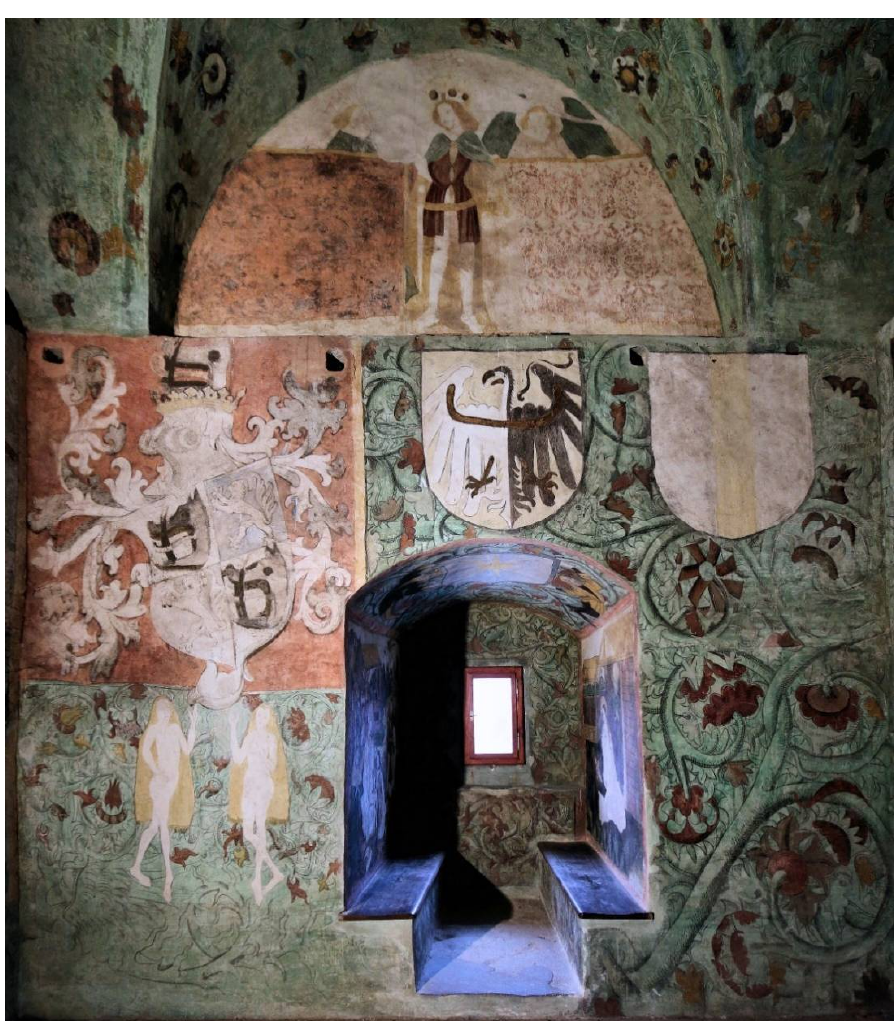
Figure 27. Blatná, castle, “green chamber“ on the second floor of the entrance tower. View of the southeast wall with the large coat of arms of the Lords of Rožmitál (located directly opposite the entrance to the room). Around 1485. Photo by František Záruba, the author’s own work.